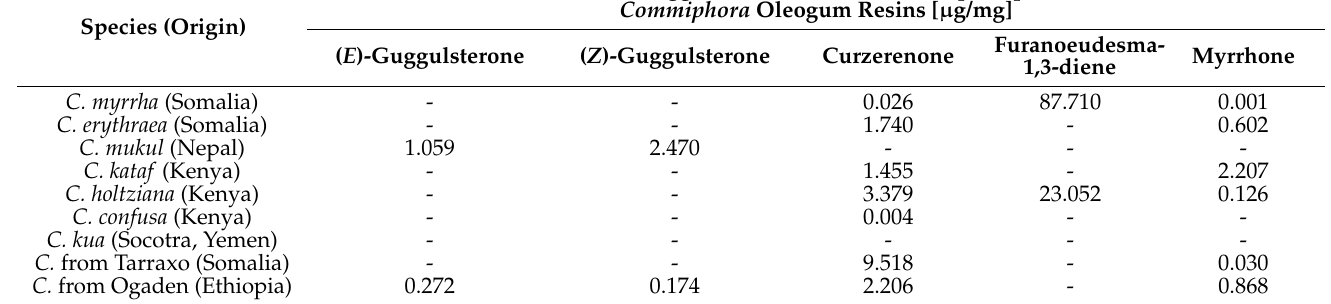
Table 3. Quantification of ( E )-guggulsterone, ( Z )-guggulsterone, curzerenone, furanoeudesma-1,3- diene, and myrrhone in Commiphora oleogum resins. Analysis by HPLC-MS/MS, in duplicates. Contents below limit of quantification or detection (<LOQ/<LOD) are indicated as “-”.